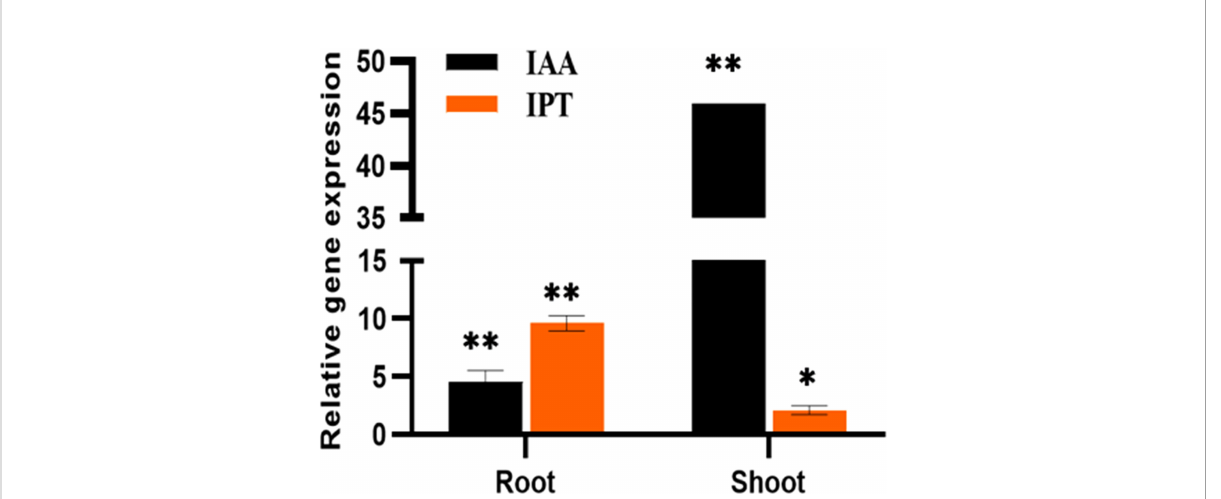
FIGURE 4 The relative expression of phytohormones, IAA and IPT genes of P. indica colonized and non-colonized plants 60 DAI. Data based on mean fold changes ± SE of three biological replicates. Asterisks indicate signi fi cance at ** P < 0.01 and * P < 0.05 by student t- test.